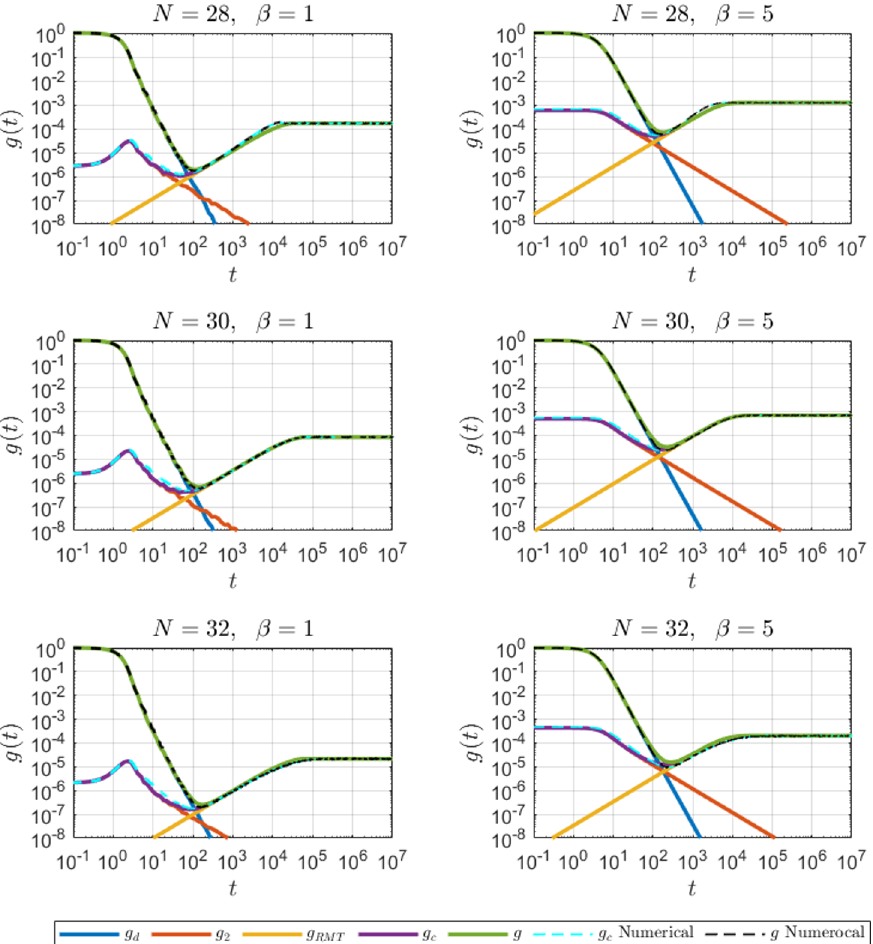
Figure 23 . A comparison of the leading order correction to the spectral form factor for N = 28 , 30 , 32 to the numerical results from